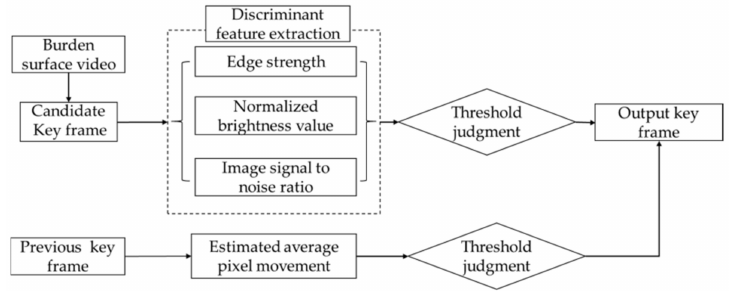
Figure 10. Key frame discriminator for burden surface